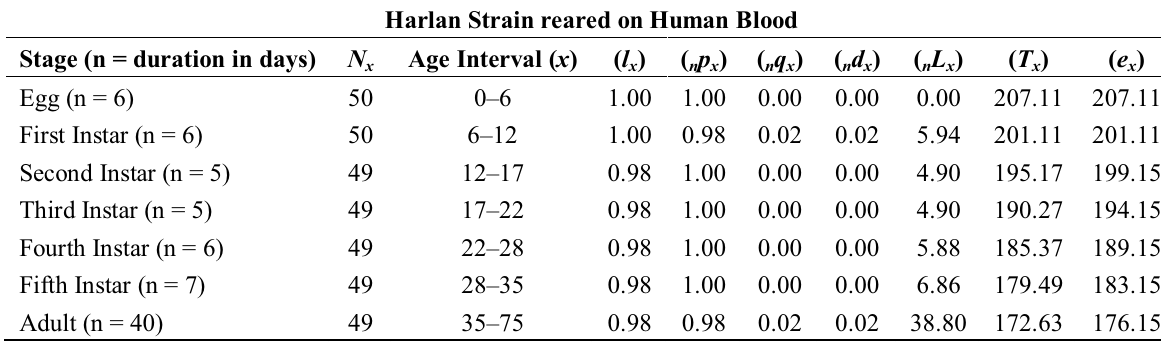
Table 1. Stage specific life table of Harlan strain Cimex lectularius on human blood. Harlan Strain reared on Human